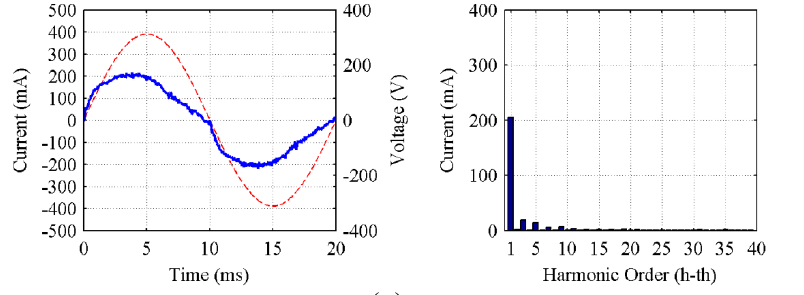
Figure 9. Type D LED spot: ( a ) current waveform and its spectrum; ( b ) thermal